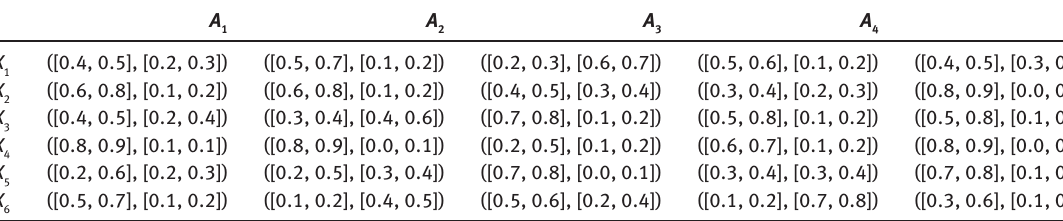
Table 1: Interval-Valued Intuitionistic Fuzzy Decision Matrix. A